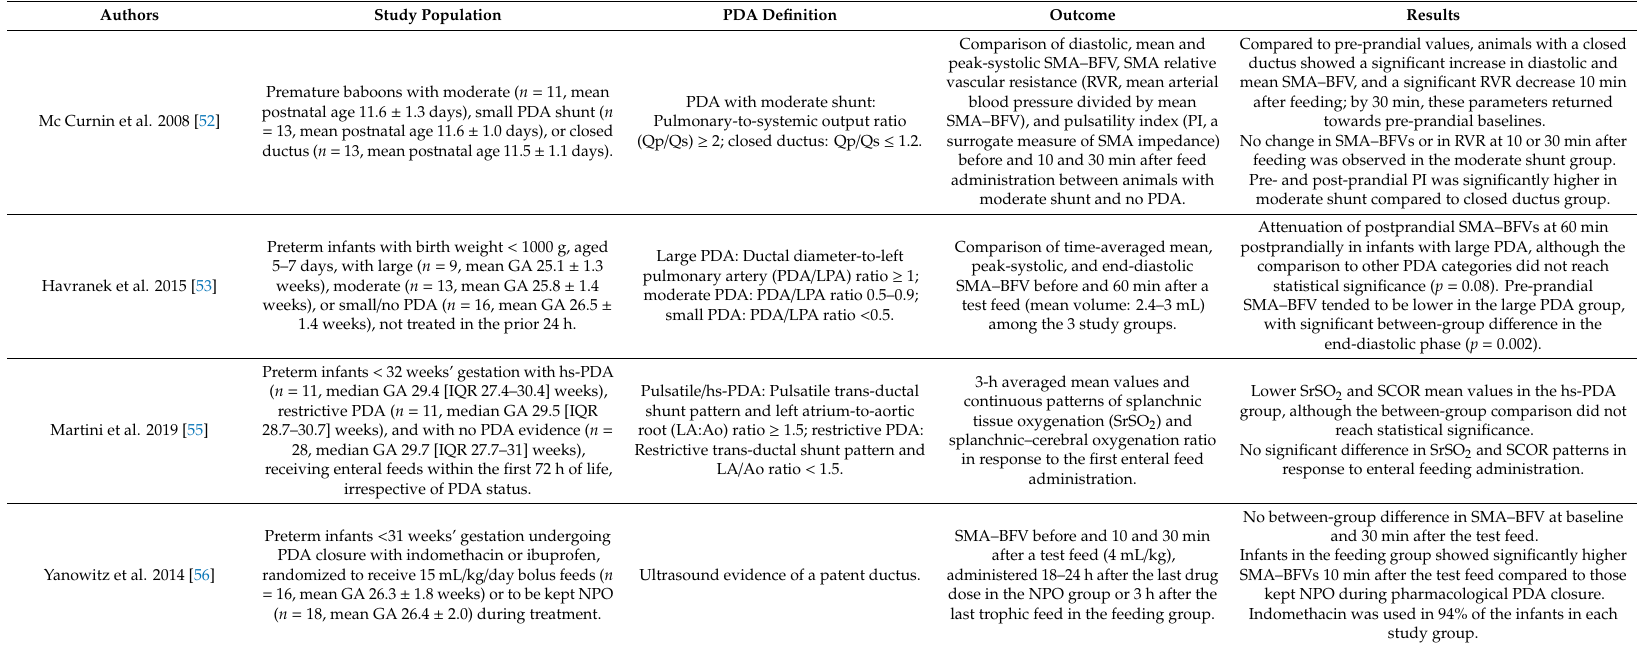
Table 1. E ff ects of patent ductus arteriosus (PDA) and of the pharmacological agents adopted for its closure on splanchnic hemodynamic response to enteral